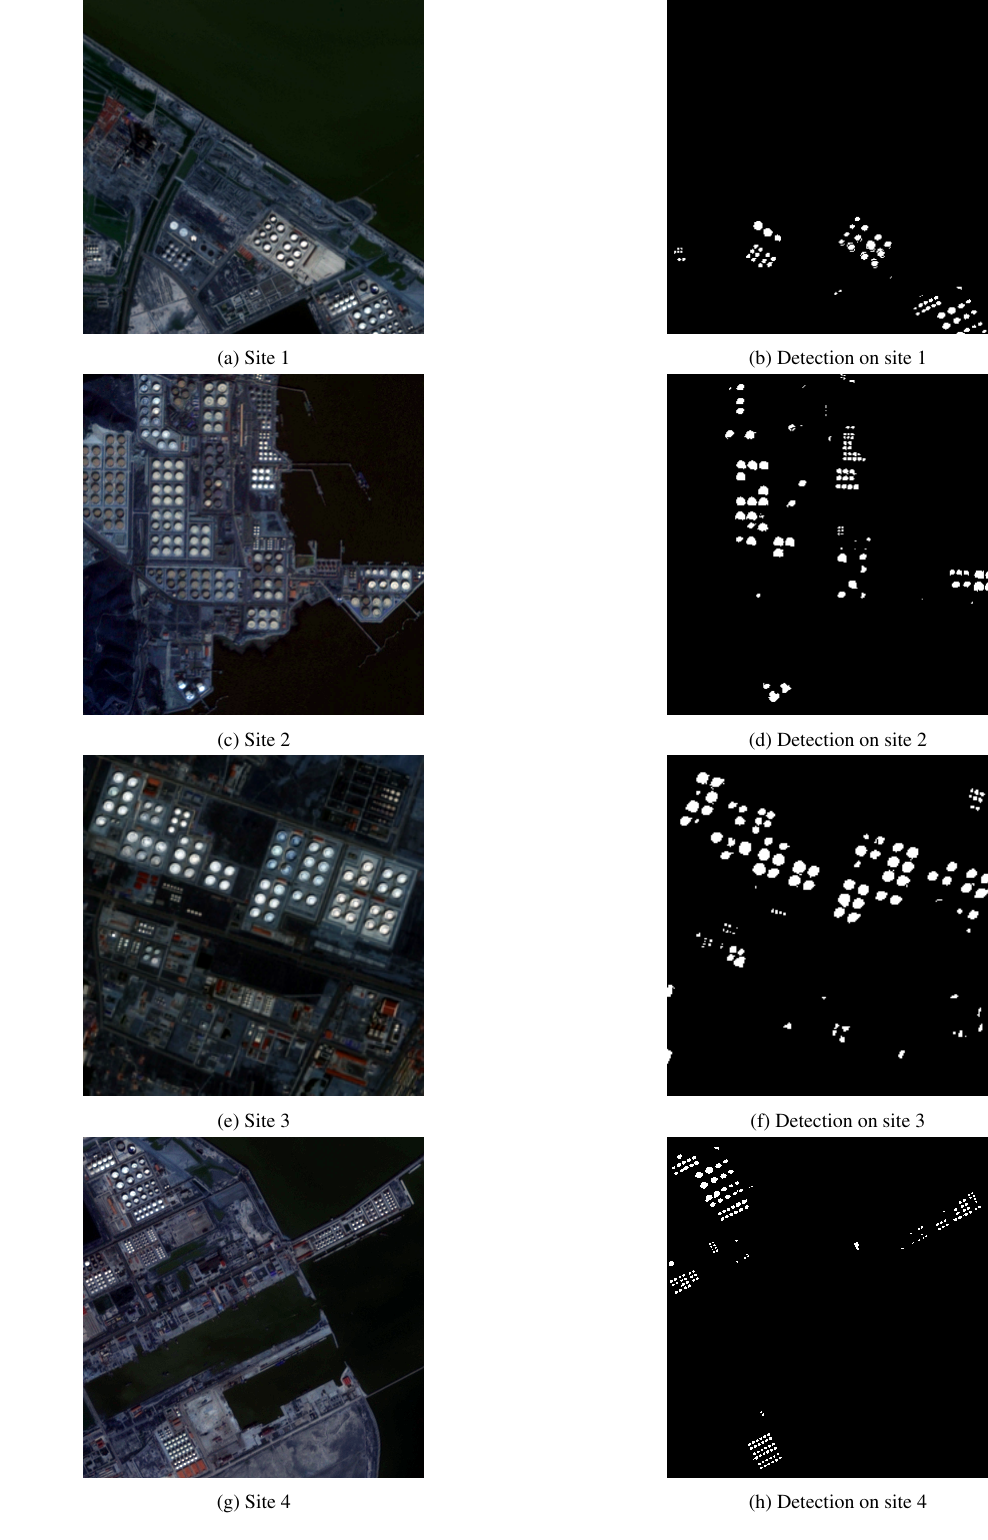
Figure 12. Results of the circle detection using level-lines detections and isoperimetric thresholding. Left column: Input image, Right column: Detection result. Low contrast area and dark tanks are hardly detected, while small tanks are accurately